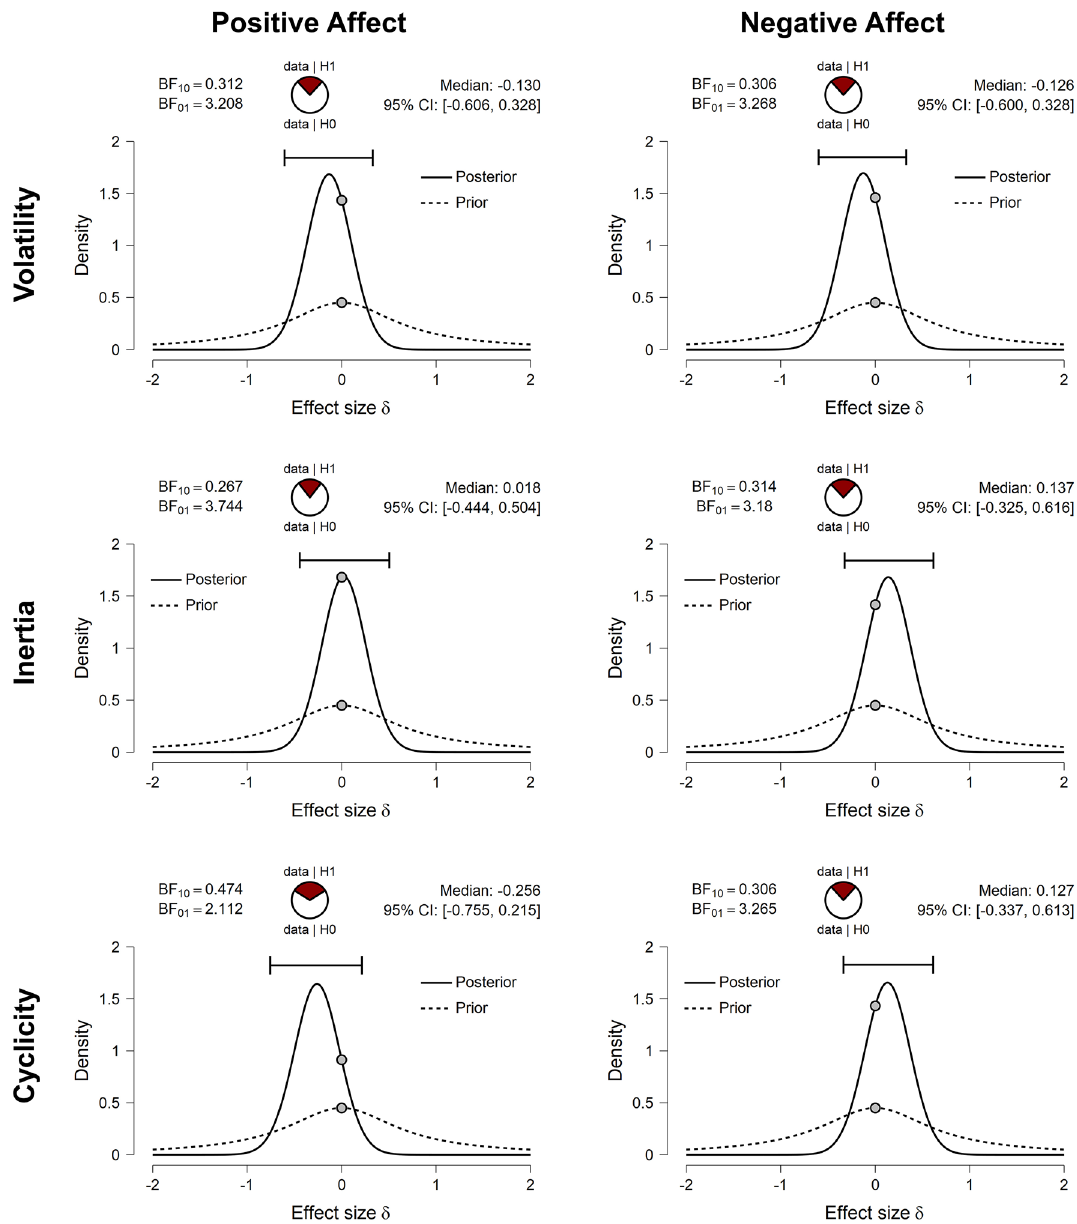
Figure 2. JASP 54 graphical output for the comparison between men and naturally cycling (NC) women on each positive and negative affective variability index using Bayesian t -tests. Density plots indicate the prior probability distribution (dashed lines) and posterior probability distribution (solid lines) of the effect size (δ) for each test, with gray dots indicating the prior and posterior probability of δ = 0 (the point null hypothesis reflecting no sex difference) and the black horizontal error bar indicating the 95% credible interval (CI) of the posterior distribution (i.e., likely size of a sex difference if one exists). Bayes factors for the alternative hypothesis (δ ≠ 0; BF 10 ) and the point null hypothesis (δ = 0; BF 01 ), proportion wheels representing the strength of evidence each Bayes factor provides 53 , and the values of the posterior median and CI are all reported above each density